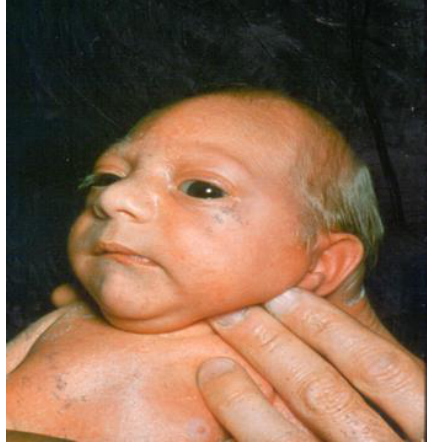
Figure 1. Newborn Infant with congenital microcephaly.